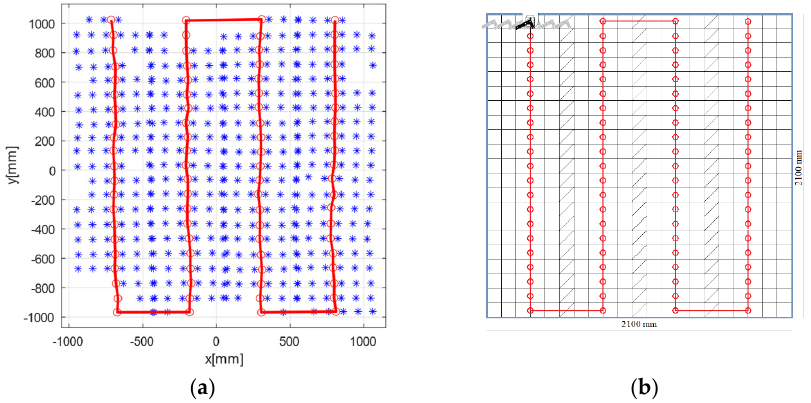
Figure 7. ( a ) Measured robot motion, with the stop positions in blue. The red dots are the sweep line’s centre, where the robot is relocated. ( b ) Robot motion test procedure.